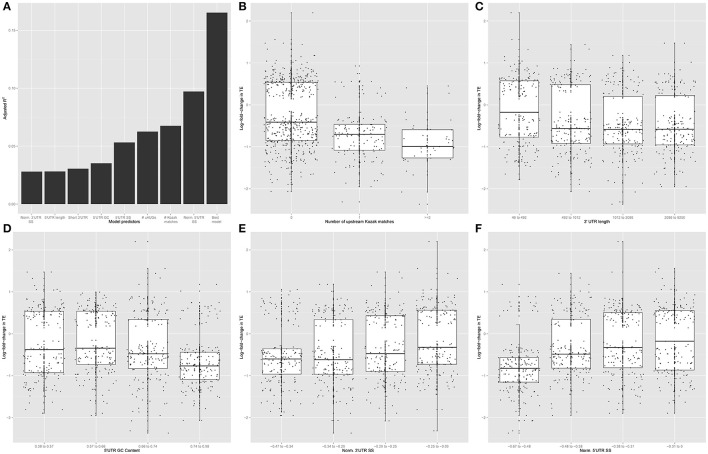
Primary sequence features alter the response to KCl stimulation. (A) Normalized 3′UTR secondary structure, 5′UTR length, short 3′UTR, 5′UTR GC content, 5′UTR secondary structure, the number of uAUGs, the number of upstream Kozak matches, and normalized 5′UTR secondary structure score were each significant individual predictor in a univariate linear model (p < 0.001). The number of upstream Kozak matches, normalized 5′UTR secondary structure, and short 3′UTR all contributed significantly to the ability of a multivariate linear model to predict the change in CDS TE in response to KCl stimulation. (B) Among transcripts that change CDS TE in response to KCl stimulation, more down-regulation of TE occurs with increasing number of upstream Kozak matches (ANOVA F-test, p = 7.379e-14, F = 31.715). Specifically, transcripts containing increasing numbers of upstream Kozak matches are disproportionately downregulated by KCl stimulation (Chi-square test, p = 2.6e-11, χ2 = 48.713). (C,D) More down-regulation of TE occurs with increasing 3′UTR length (ANOVA F-test, p = 7.069e-05, F = 7.3975) (C) and 5′UTR GC content (ANOVA F-test, p = 6.72e-09, F = 14.084) (D). (E,F) More up-regulation of TE occurs with decreasing absolute value of length-normalized 3′UTR secondary structure (ANOVA F-test, p = 6.221e-06, F = 9.1461) (E) and 5′UTR (ANOVA F-test, p = 3.695e-16, F = 26.492) (F).